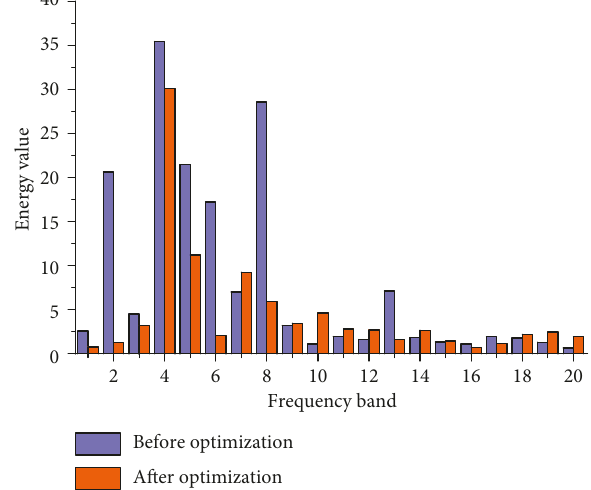
Figure 23: Energy value with frequency band